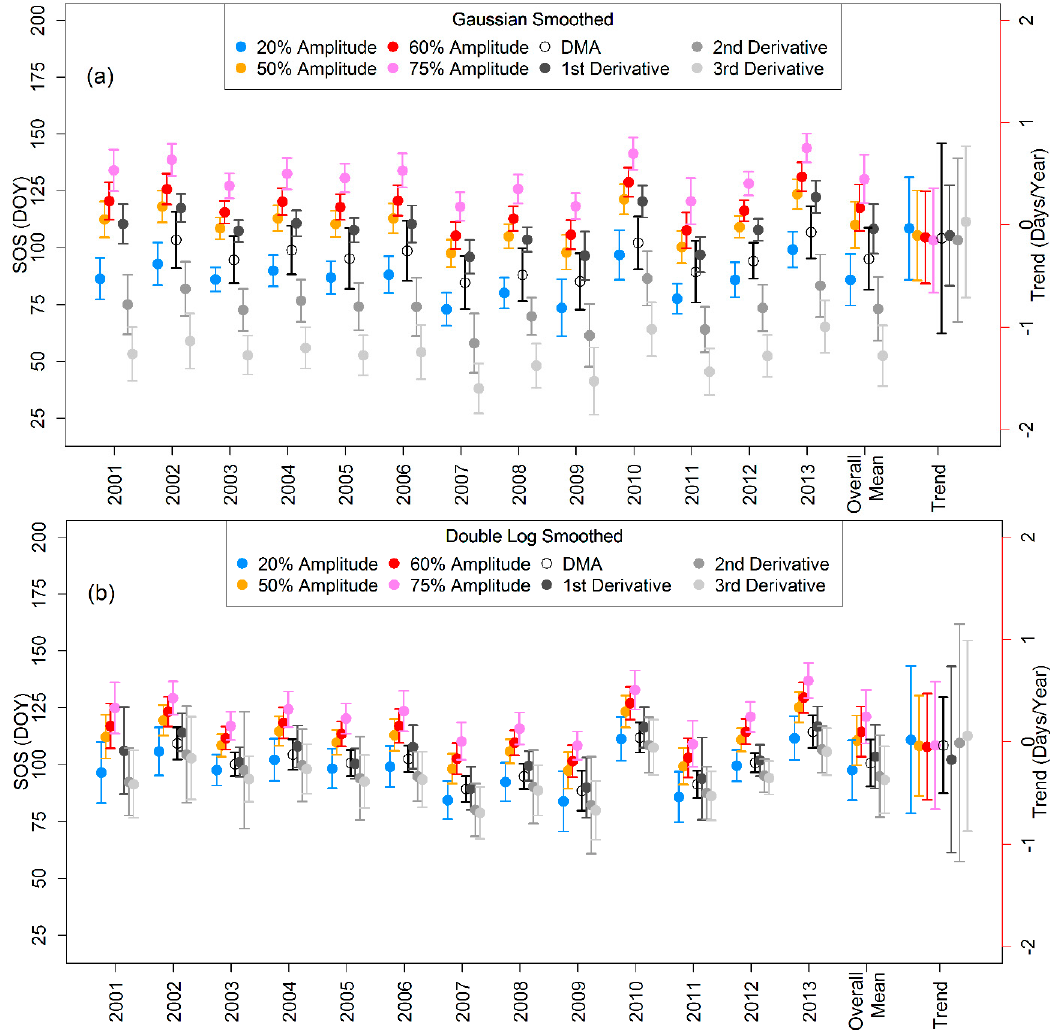
Figure 3. LSP-SOS from ( a ) Gaussian and ( b ) Double Log smoothed NDVI for broadleaf pixels using various methods (spatially averaged SOS for specific years as filled-coloured circles and one standard deviation as error bars). Overall mean is the mean SOS (2001–2013), which is a temporal and spatially averaged measure of LSP-SOS. The temporal trends in days/year (right y-axis) for all pixels’ LSP-SOS are given as means and respective one standard deviation during 2001–2013. The year-to year variability in SOS reflects the different spring weather patterns.